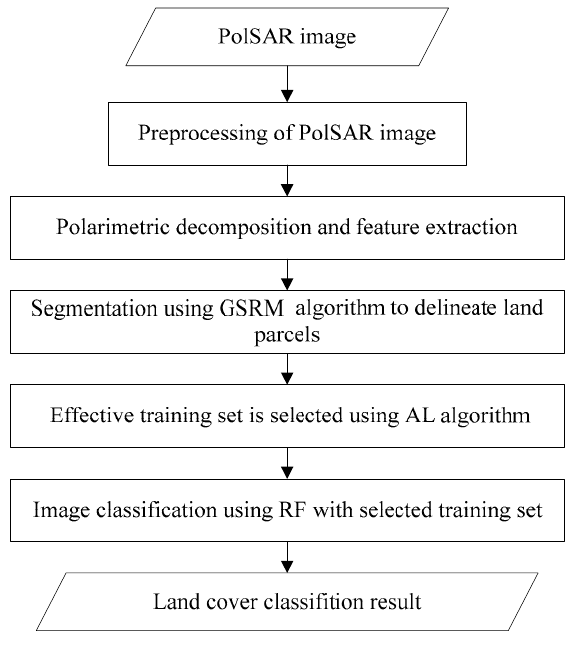
Figure 1. The process flow of the proposed method.